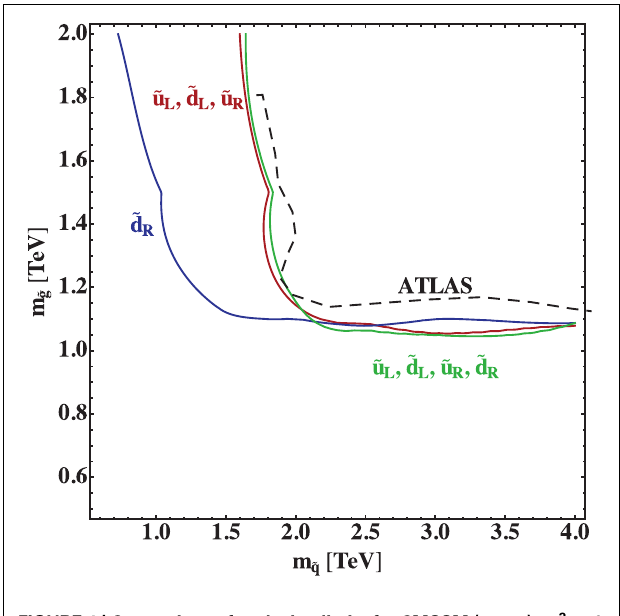
FIGURE 4 | Comparison of exclusion limits for CMSSM (green), m 2 < 0 (red) simplified models with the ATLAS limit (blue), and m 2 D (dashed